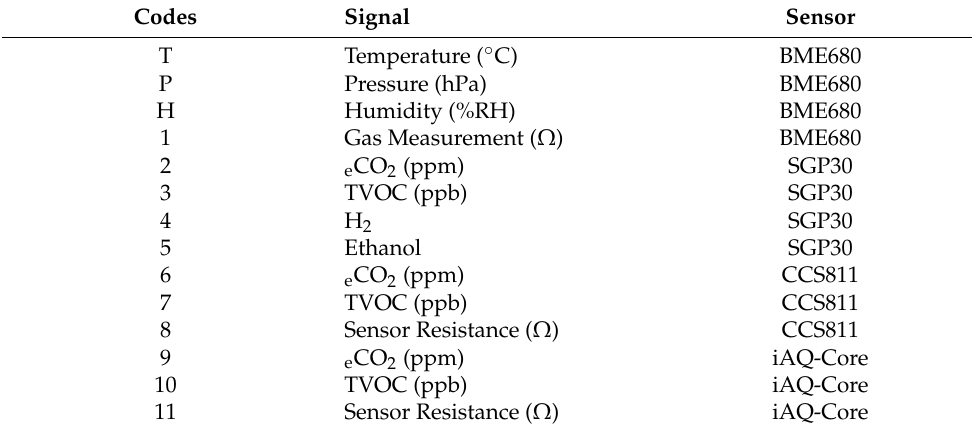
Table 1. Description of the 11 signals generated by the E-nose device.